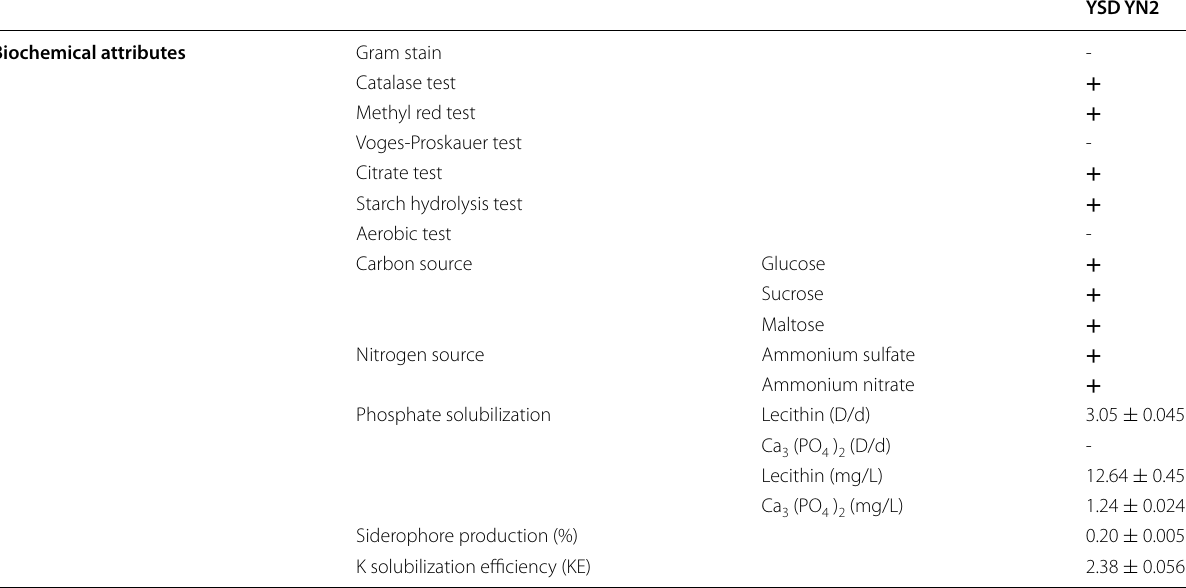
Note: ( ) positive reaction; (-) negative reaction. Results are means + repetitions. D/d , transparent zone diameter/ colony